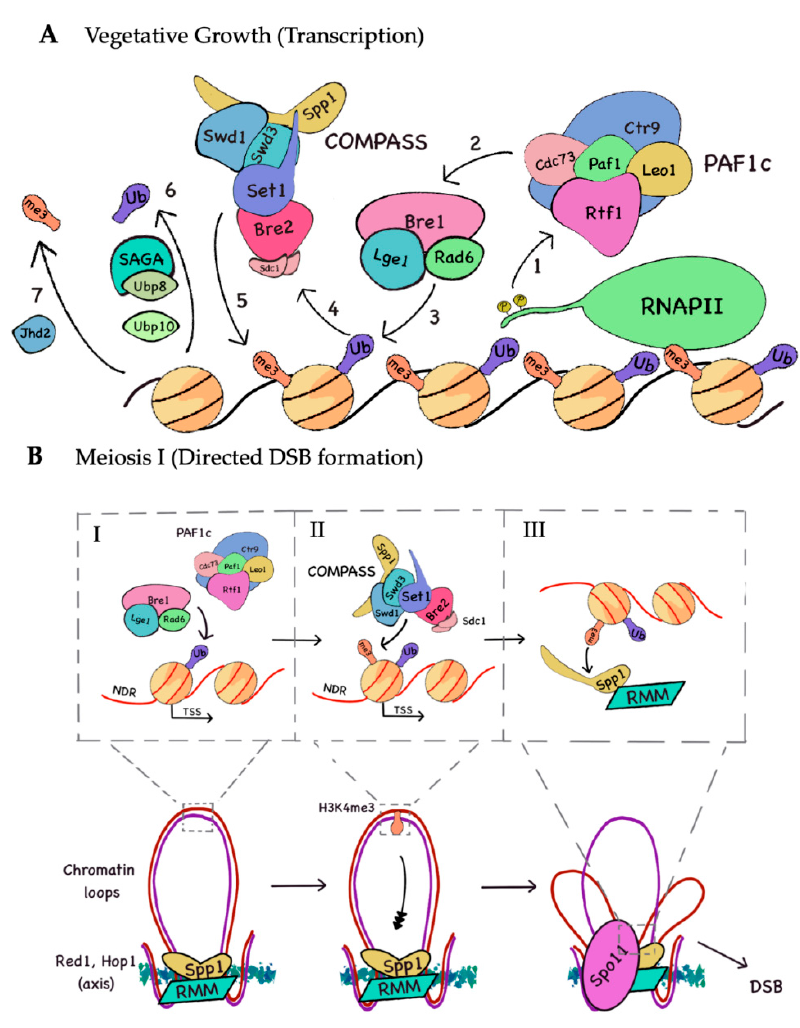
Figure 5. Role of H2Bub and H3K4me3 in transcription and DSB formation. ( A ) General overview of the cross-talk. PAF1c recognizes RNA polymerase II (RNAPII) phosphorylated on the S2 and S5 of its